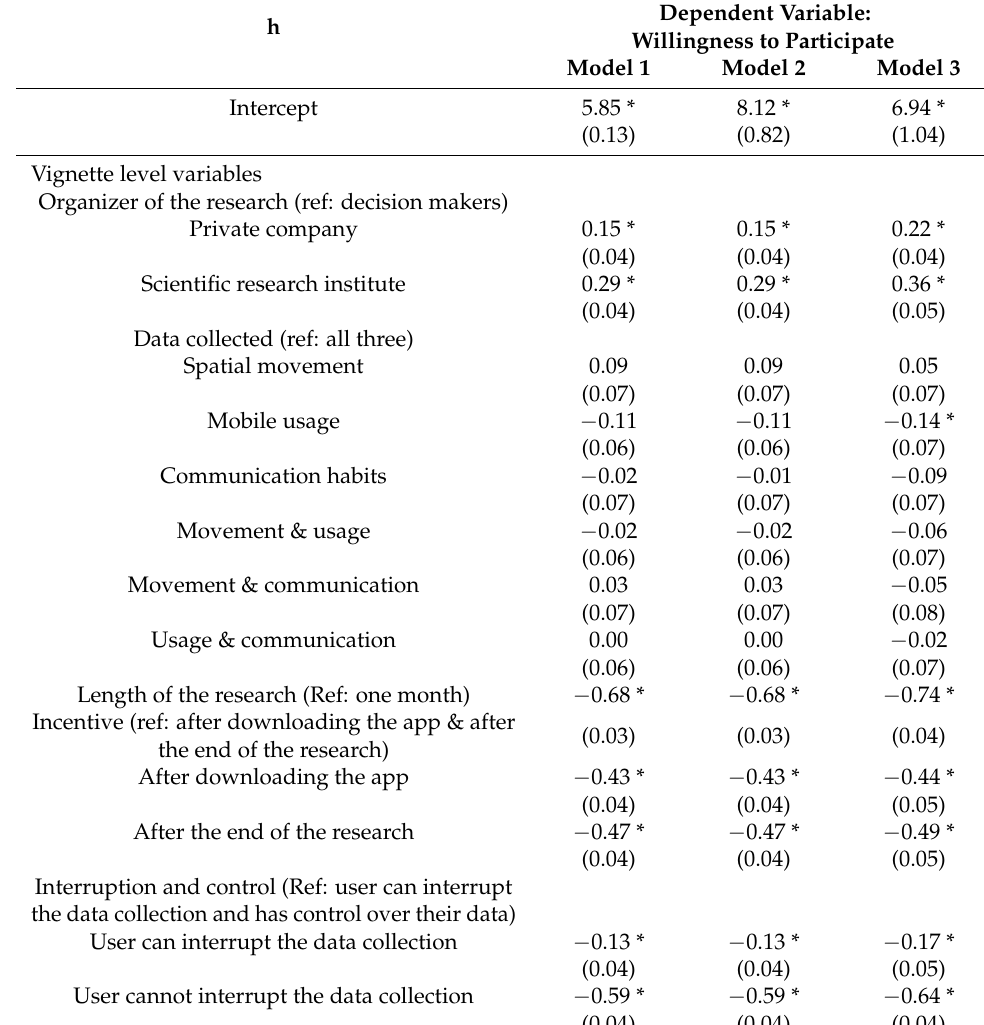
Table 3. Multilevel Regression Models on the Willingness to